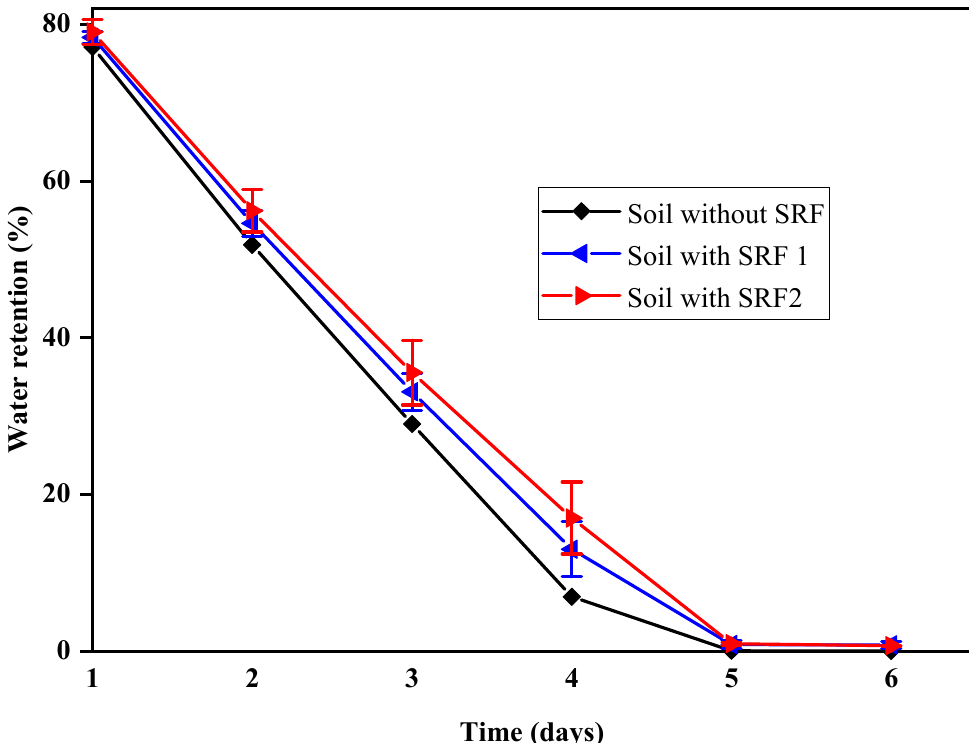
Figure 6. Water retention behaviour of sandy soil with and without hydrogel .